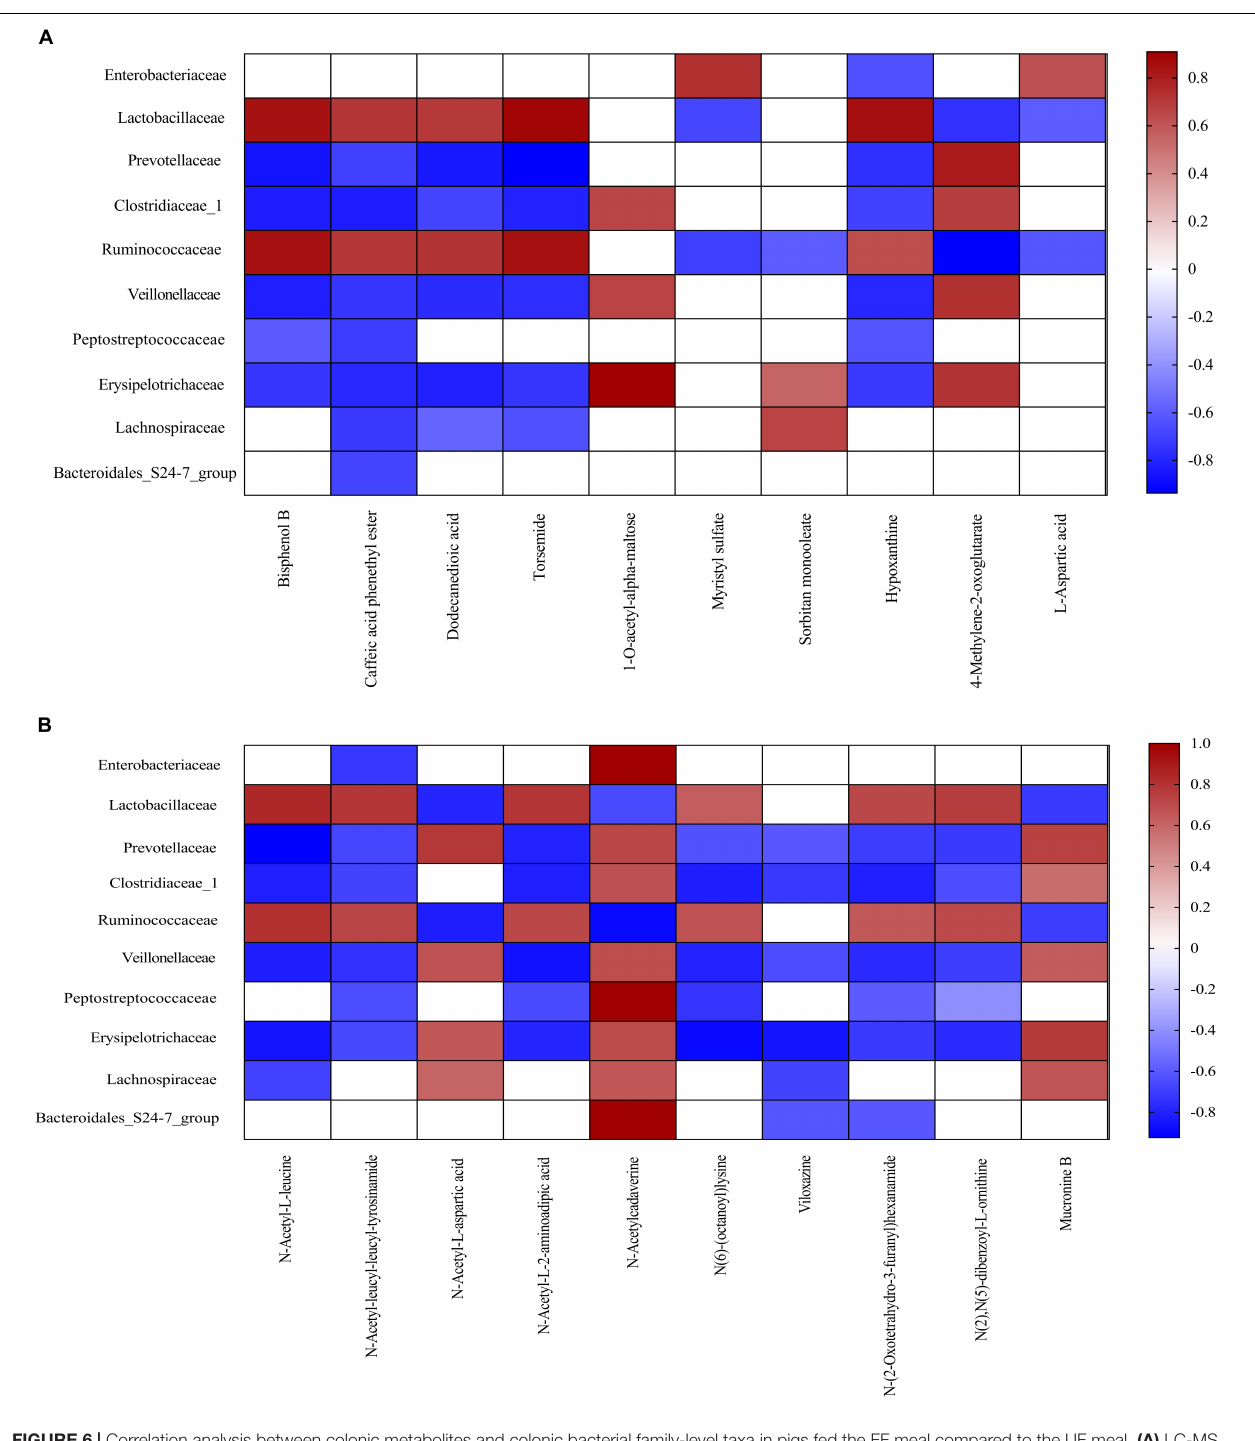
FIGURE 6 | Correlation analysis between colonic metabolites and colonic bacterial family-level taxa in pigs fed the FF meal compared to the UF meal. (A) LC-MS (ESI–). (B) LC-MS (ESI+). The color represents a significant correlation ( P < 0.05), and the intensity of the colors represents the degree of association. Red represents significant positive correlation and blue represents significantly negative correlation ( n =